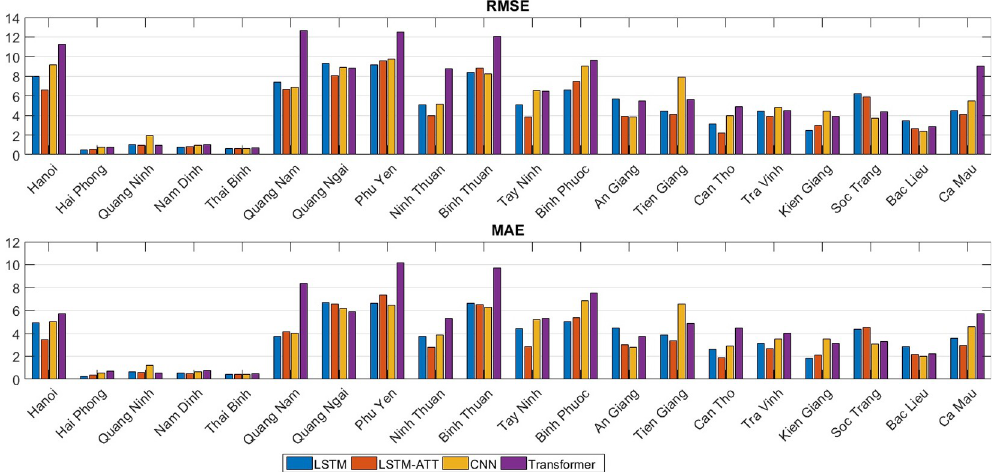
Fig 4. RMSEs and MAEs for all models (LSTM, and LSTM-ATT, CNN, Transformer) for all 20 provinces. The smaller the values, the better the prediction accuracies. RMSE = root mean square error. MAE = mean absolute error. CNN = convolutional neural network. LSTM = long short-term memory. LSTM-ATT = attention mechanism-enhanced LSTM.